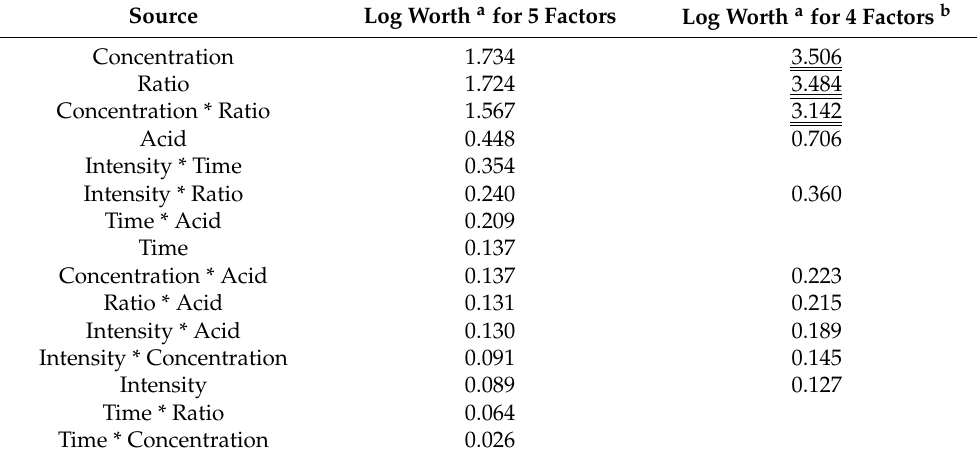
Table 7. Statistical importance of the DOE factors according to a 5- and 4-factor